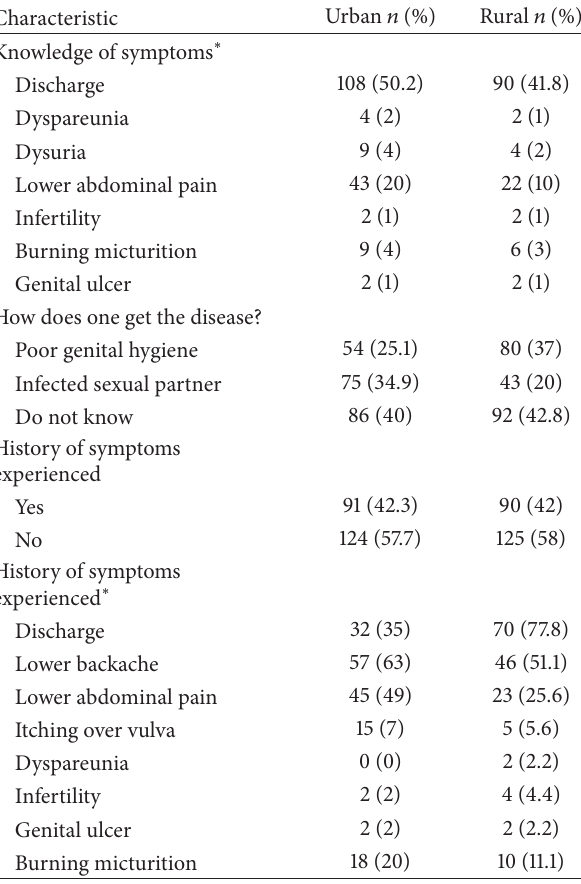
Table 3: Knowledge and prevalence of RTI/STI among study